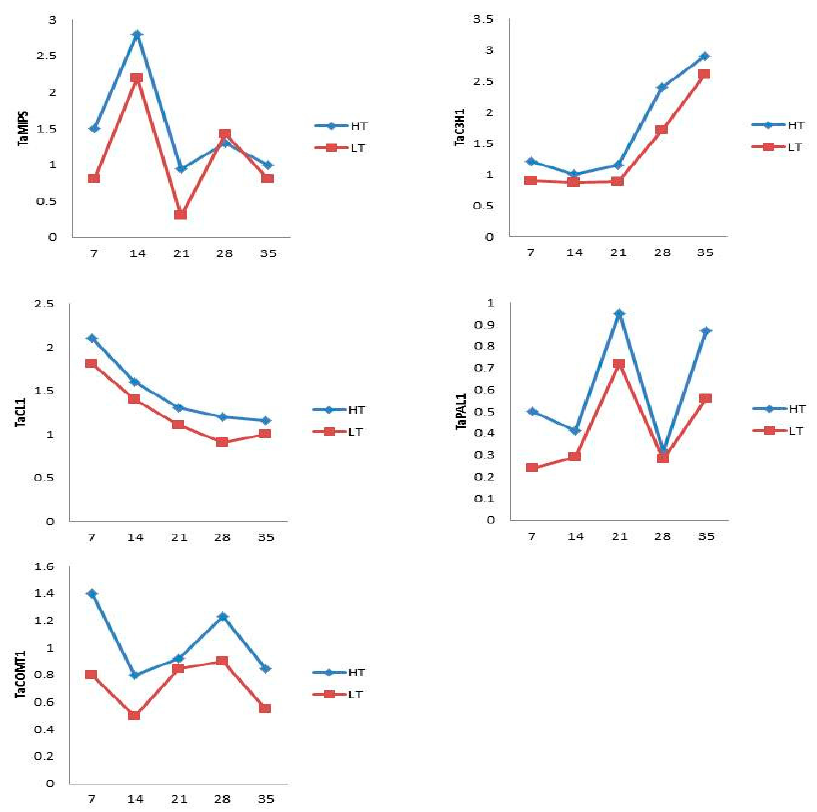
Figure 3. Relative expression level of phytic acid and phenolic acid biosynthesis genes in different temperature condition in wheat grain during grain development.